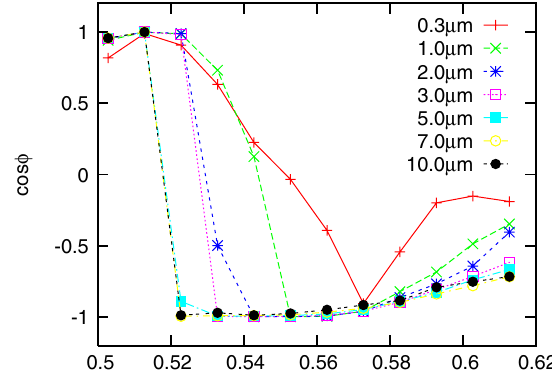
FIG. 9. Betatron phase difference between positron and elec- tron beams for the excitation frequency and amplitude.